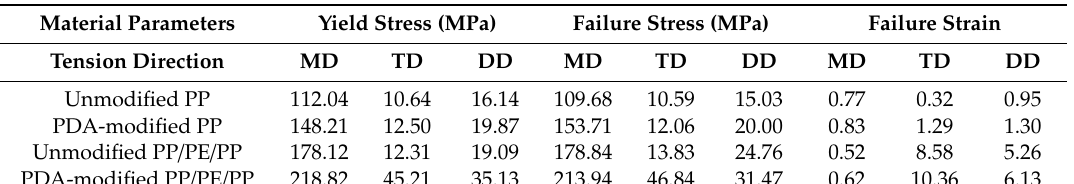
Table 4. Material parameters of unmodified and PDA-modified separators along TD, MD, and DD under strain rates 0.2 s − 1 .